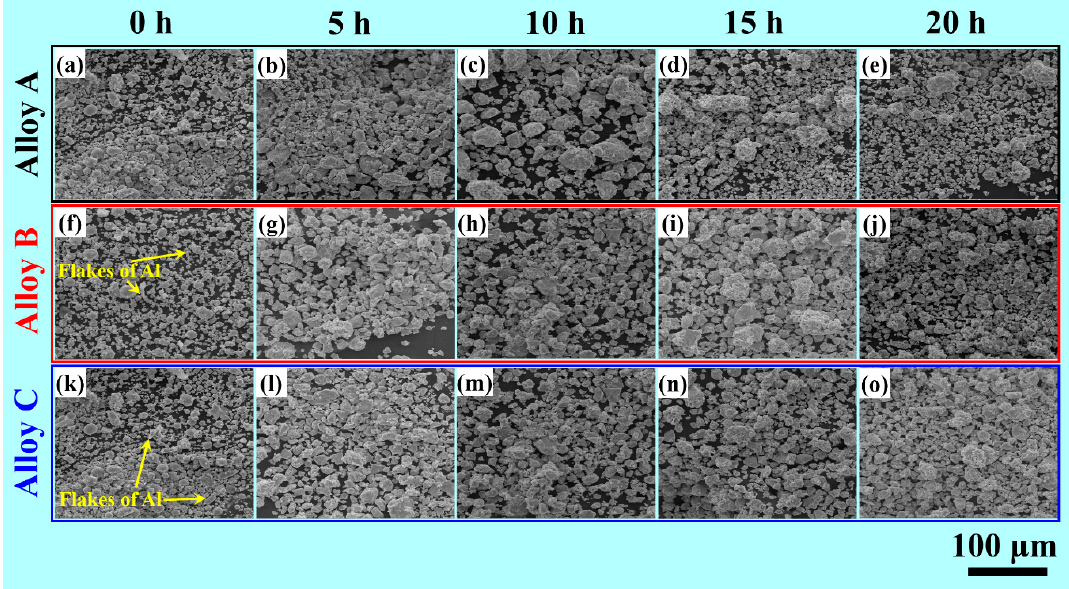
Figure 3. Scanning electron microscopy images of the mechanically alloyed powders (from ( a – e ) Alloy A, ( f – j ) Alloy B, and ( k – o ) Alloy C) as a function of milling